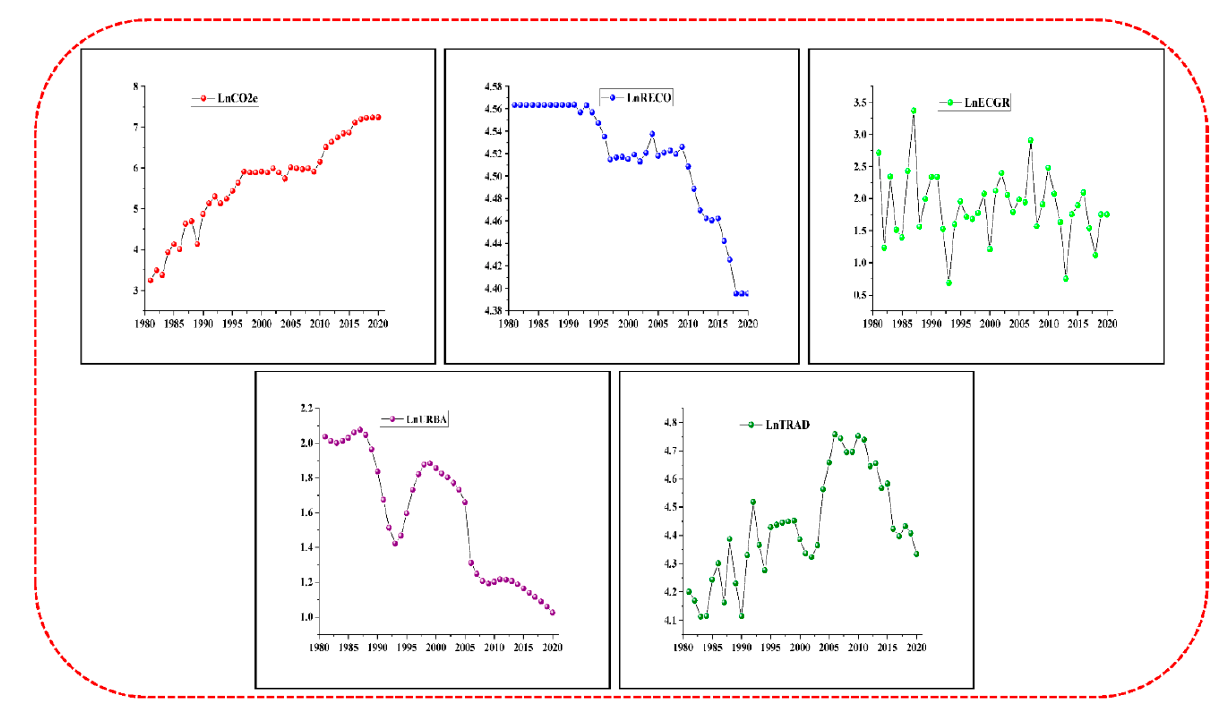
Figure 1. Variable trends.